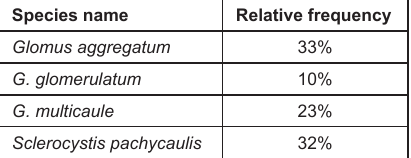
Table 1. Relative frequency of